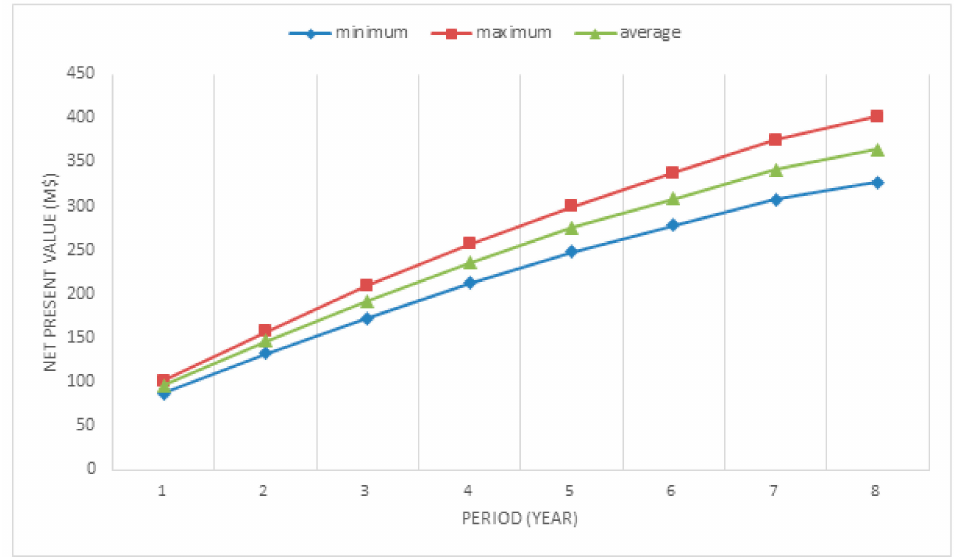
Figure 11. Undiscounted cumulative cash flow of case study deposit.